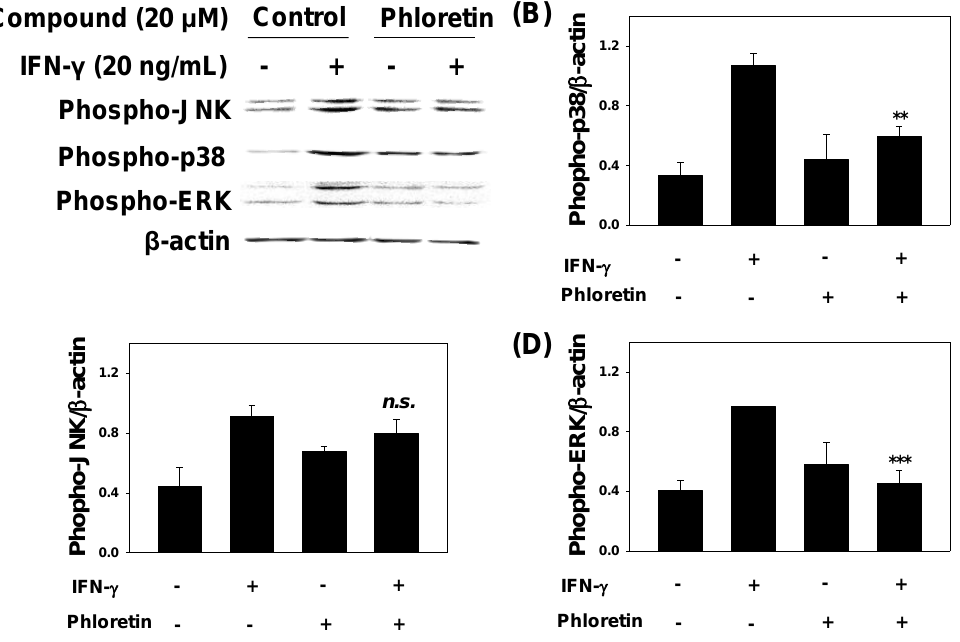
Figure 4. JNK, p38 MAPK, and ERK expression in MRC-5 cells pretreated with phloretin and stimulated with interferon (IFN)-γ. ( A ) MAPK levels were evaluated by Western blot, with β-actin used as a loading control; ( B – D ) relative intensities of phosphorylated JNK, p38 MAPK, and ERK normalized to β-actin, respectively. Data represent mean ± standard deviation. ** p < 0.005, *** p < 0.001 vs. cells treated with IFN-γ only.